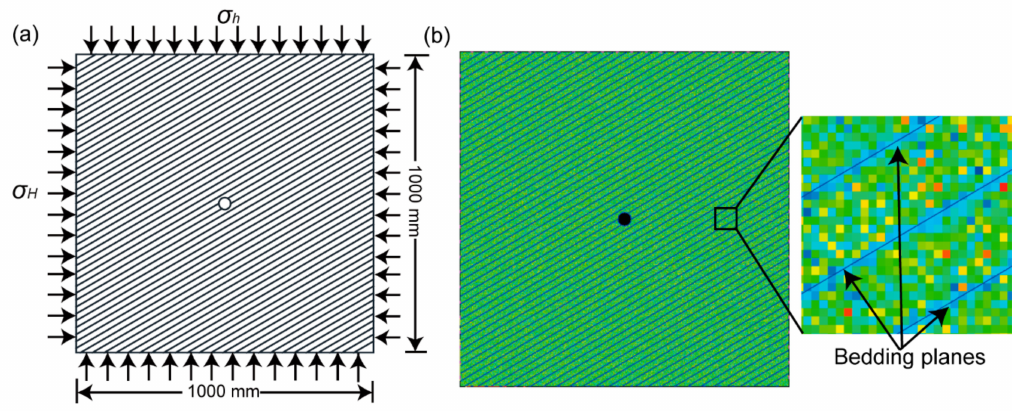
Figure 2. Numerical model setup with a plot of modulus distribution showing the bedding orientation at 30 ◦ in the model. ( a ) Geometric model; ( b ) Numerical model.